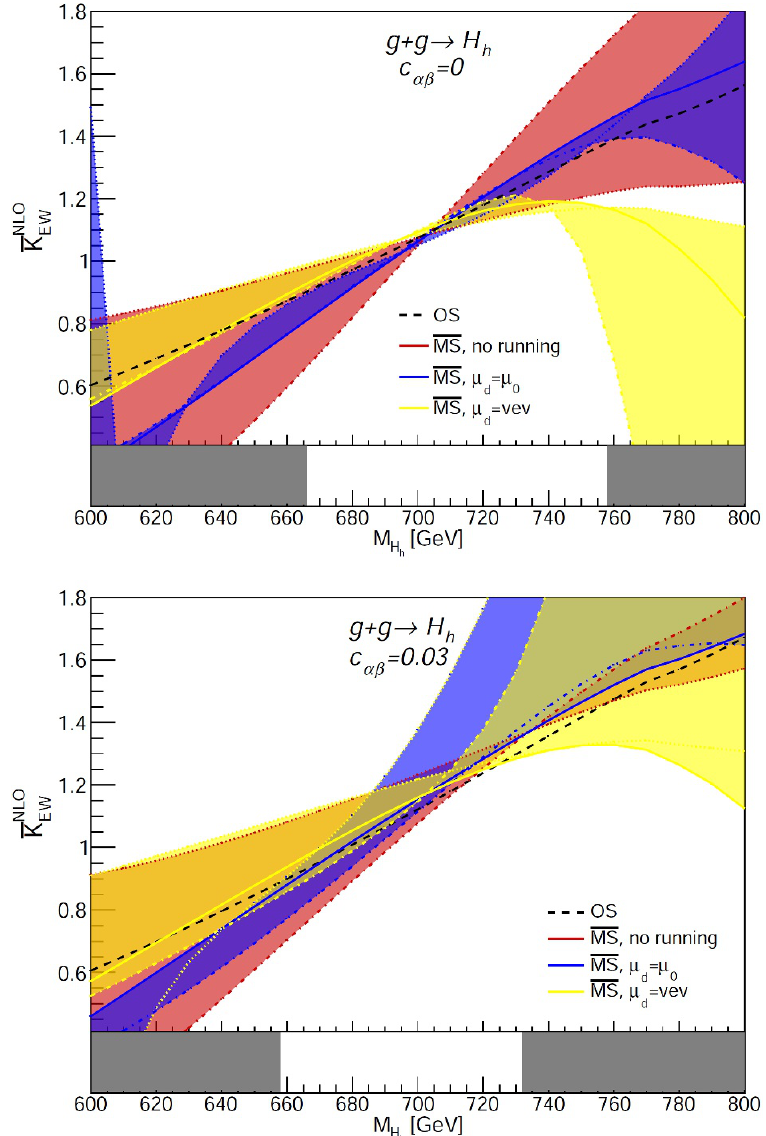
Figure 11 . The K-factors of the process g + g H h in various MS schemes are compared to the ! on-shell scheme. Solid lines are for (cid:22) = (cid:22) 0 , while dotted and dash-dotted lines refer to (cid:22) = (cid:22) 0 = 2 and (cid:22) = 2 (cid:22) 0 , respectively. The grey shaded band denotes the region where at least one of the couplings (cid:21) i = (4 (cid:25) ) ( i = 1 ; : : : 5) of the potential in eq. (2.2) becomes larger than 0.5 for at least one j j of the scales (cid:22) considered. The curve with (cid:22) = (cid:22) 0 for the case of the MS scheme without running coincides with the (cid:22) = (cid:22) 0 curve for the MS scheme with running, where the parameters are de(cid:12)ned at (cid:22) d = (cid:22) 0 , since in both cases the parameters have been de(cid:12)ned at (cid:22) 0 .